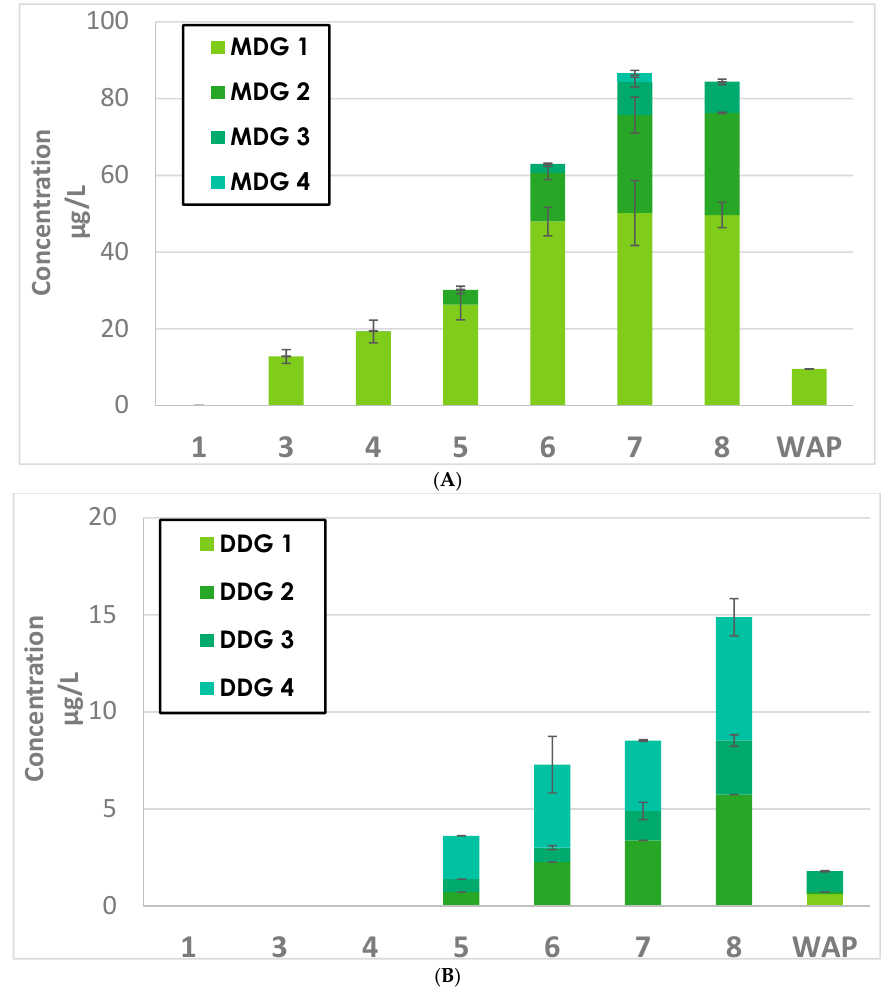
Figure 3. Evolution of ( A ) monomers of (epi) catechin diglycosides (MDG) and ( B ) dimers of (epi) catechin diglycosides (DDG) during GRE fermentation. Molecules 2018 , 23 , 3300